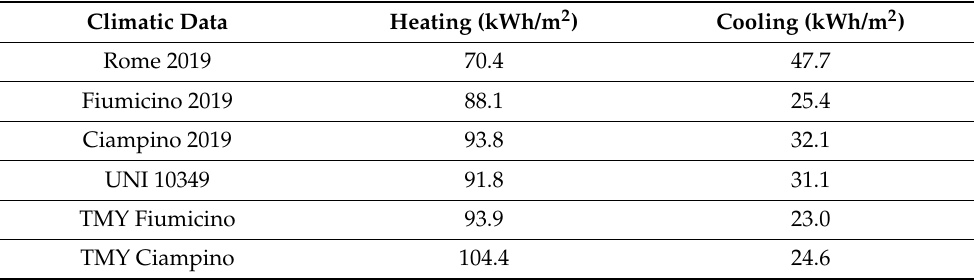
Table 3. Sample building energy